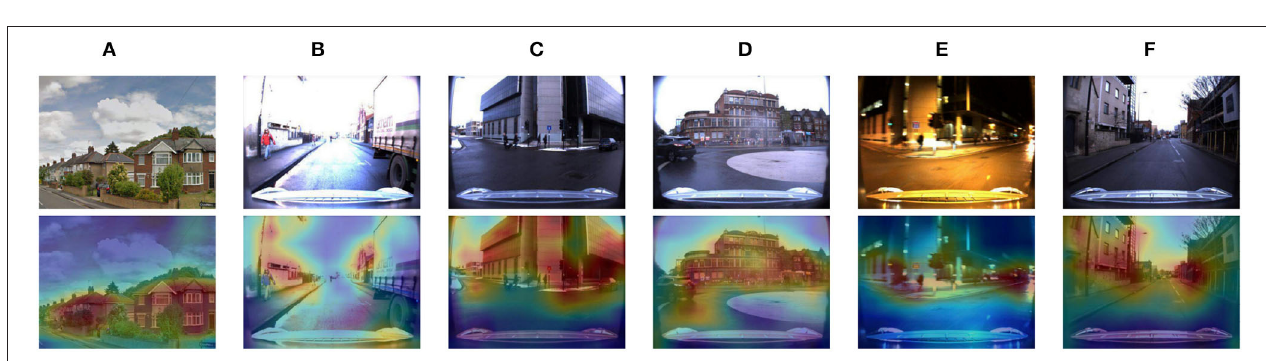
FIGURE 3 | The proposed architecture. First, a domain-driven data augmentation method is used to generate a labeled pseudo-target dataset from the source dataset and just 5 unlabeled target images. Then, the source dataset, pseudo-target dataset, and the 5 unlabeled target images are used to train the network that extracts the image descriptors. This network leverages an attention layer and a domain adaptation module to provide robustness to domain shifts. The difference between AdAGeo and AdAGeo-Lite is in the implementation of the domain-driven data augmentation.